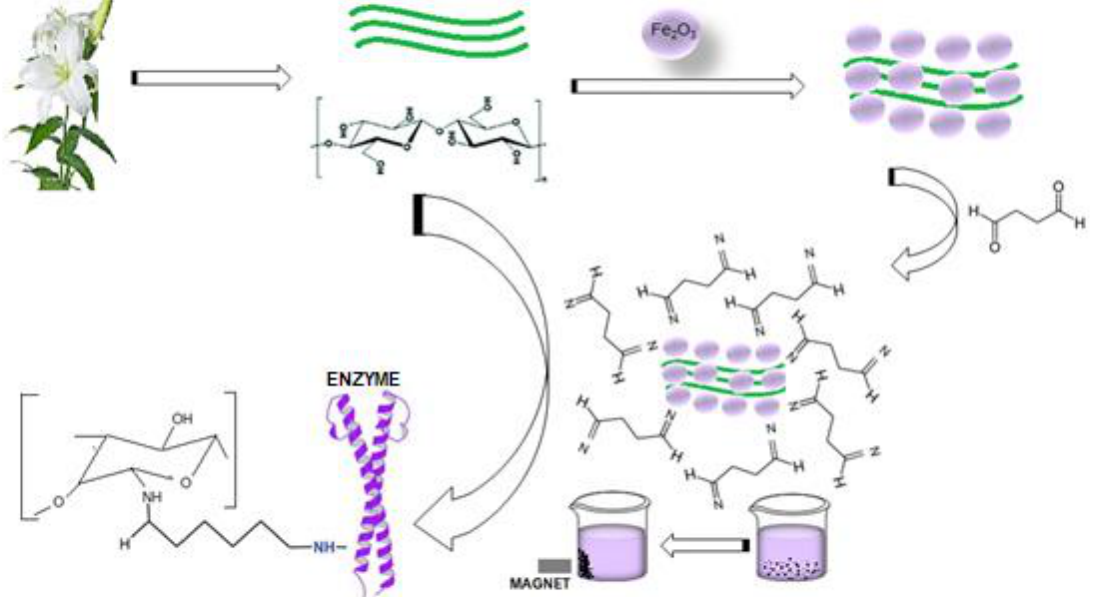
Figure 9. Reaction mechanisms of the cellulosic structures of LFs ( Lilium candidum L.) modified with glutaraldehyde and immobilization of pectin lyase enzyme to support